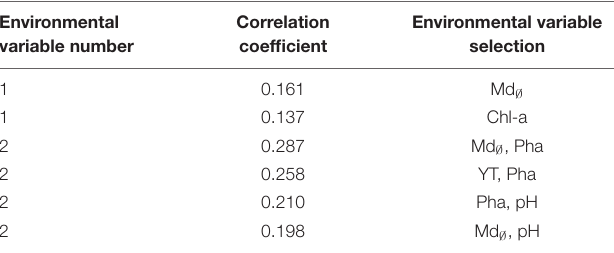
TABLE 5 | BIOENV analysis of meiofauna and environmental